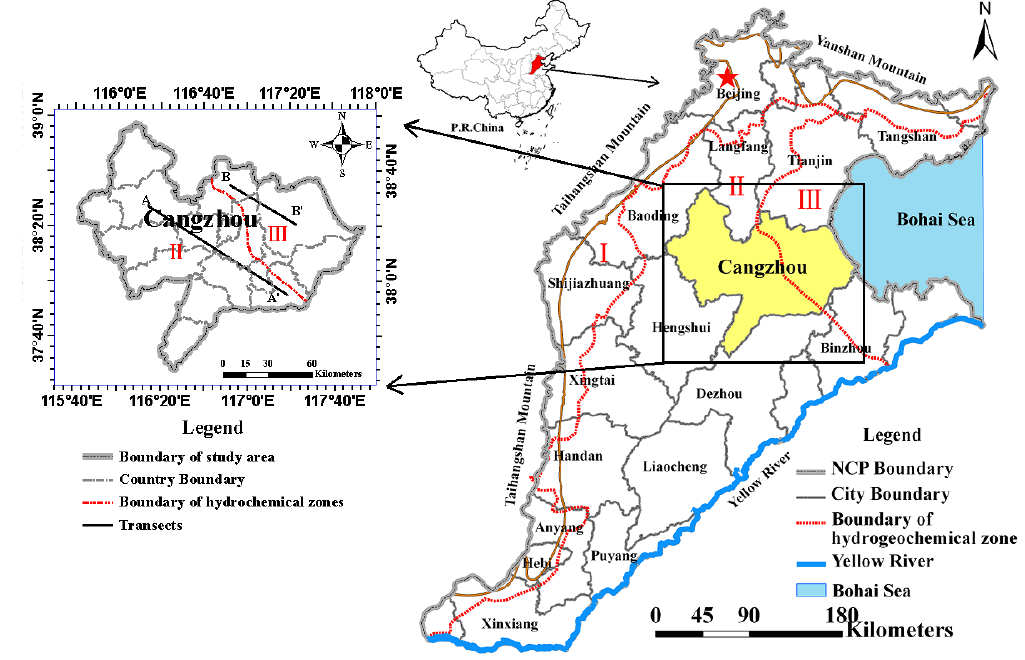
Figure 1. Map of the geographical location and distribution of hydrogeochemical zones and transects (A–A' and B–B') in